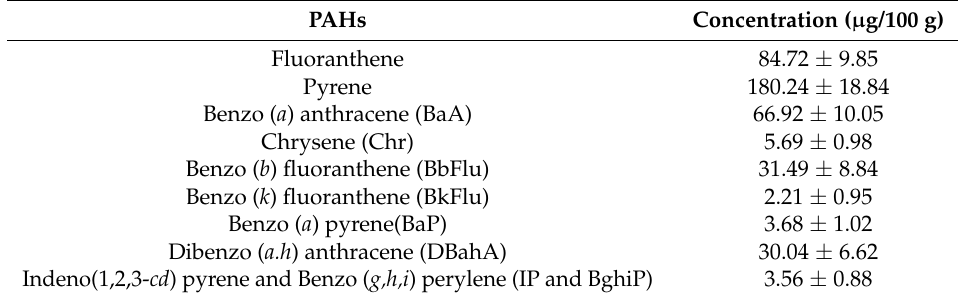
Table 3. Polycyclic aromatic hydrocarbons (PAH) in chia seed